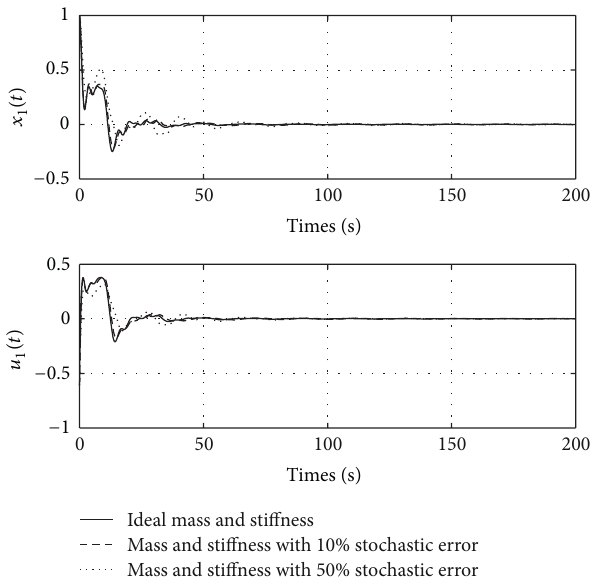
Figure 13: Effect of mass and stiffness stochastic errors on the displacement response and the control input for mass 1.